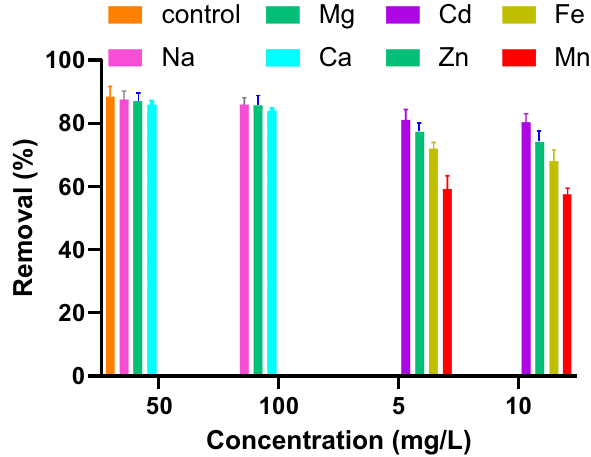
Figure 10. Effect of co-existing ions on Pb(II) adsorption by PG (adsorbent dosage: 10 g/L, Pb(II): 10